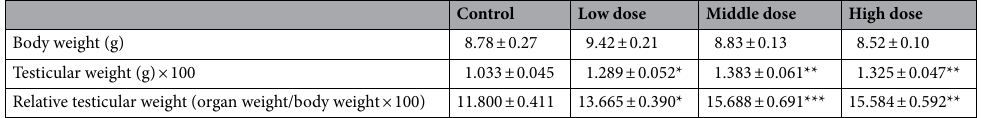
Table 2. Body and testicular weights of CORT-administered mice on PND 16. Values are expressed as the mean ± S.E.M. of 12 samples per group. *p < 0.05, **p < 0.01, and ***p < 0.001. CORT corticosterone.